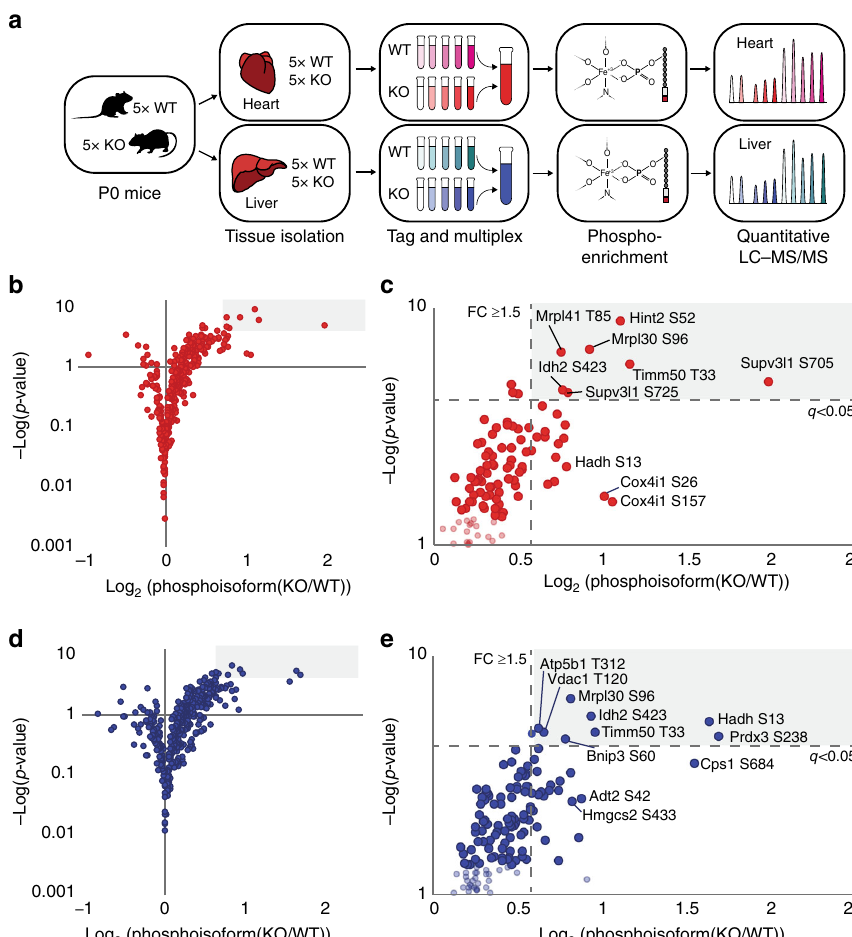
Fig. 4 Phosphoproteomic analyses reveal candidate Pptc7 substrates. a Schematic of multiplexed, quantitative phosphoproteomics for Pptc7 WT and KO heart (red) and liver (blue) tissues ( n = 5 for each genotype in each tissue). b Volcano plot showing mitochondrial phosphoisoforms as Log 2 (fold change) in Pptc7 KO versus WT heart. Shaded region corresponds to identi fi ed events with ≥ 1.5-fold change and a Benjamini – Hochberg multiple hypothesis- adjusted q -value of < 0.05. c Zoom in of shaded region in b showing select statistically signi fi cant phosphoisoforms that are candidate Pptc7 substrates. d Volcano plot showing mitochondrial phosphoisoforms as Log 2 (fold change) in Pptc7 KO versus WT liver. Shaded region corresponds to identi fi ed events with ≥ 1.5-fold change and a Benjamini – Hochberg multiple hypothesis-adjusted q -value of < 0.05. e Zoom in of shaded region in d showing select statistically signi fi cant phosphoisoforms that are candidate Pptc7 substrates. Source data for panels b – e . are provided as Supplementary Datasets 1 and